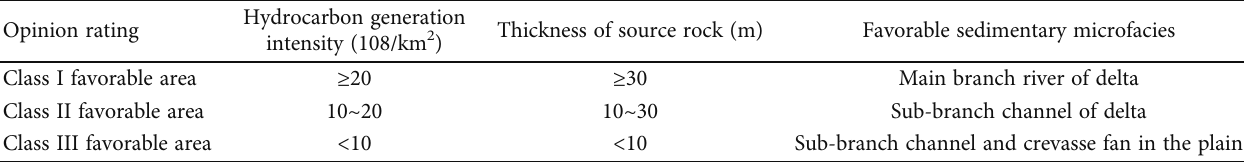
Table 4: Prediction standard of favorable natural gas exploration area of Taiyuan-Shanxi Formation in study